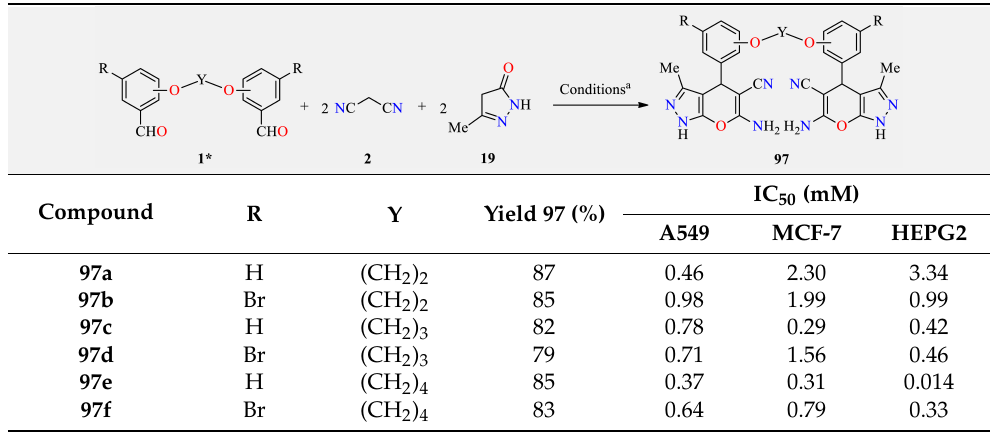
Table 29. Pseudo five-component synthesis and anticancer activity of bis -1,4-dihydropyrano[2,3- c ]pyrazole-5-carbonitrile derivatives 97